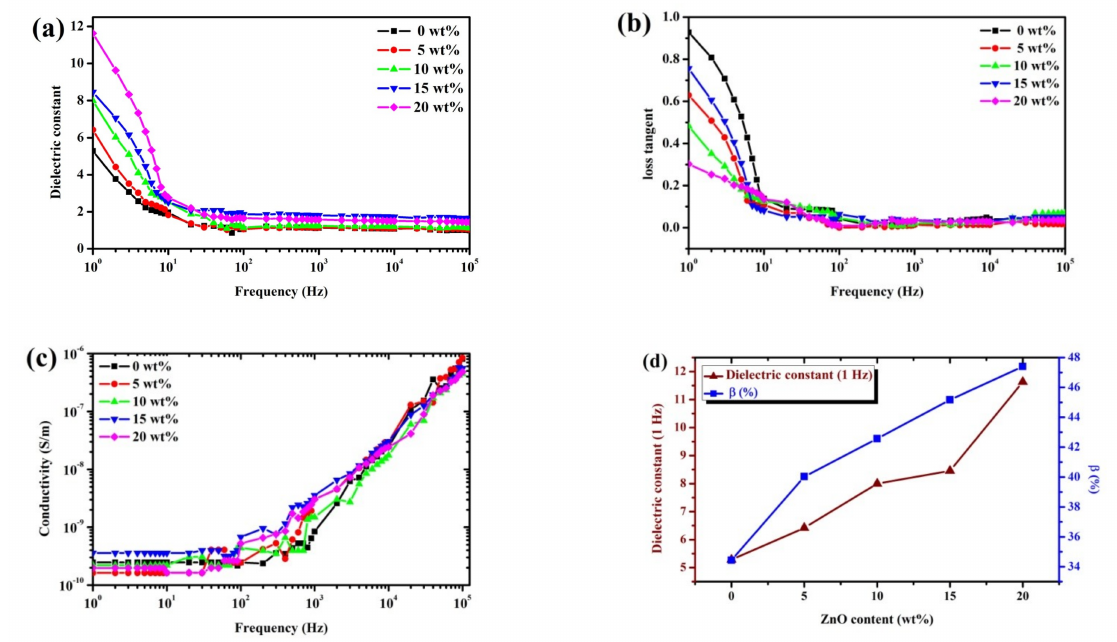
Figure 9. Room temperature frequency-dependent ( a ) dielectric constant; ( b ) dielectric loss; ( c ) AC conductivity of P(VDF- HFP)/ZnO nanocomposites with 0, 5, 10, 15, and 20 wt% ZnO content, respectively; and ( d ) the effect of the ZnO content on the dielectric constant and absolute β